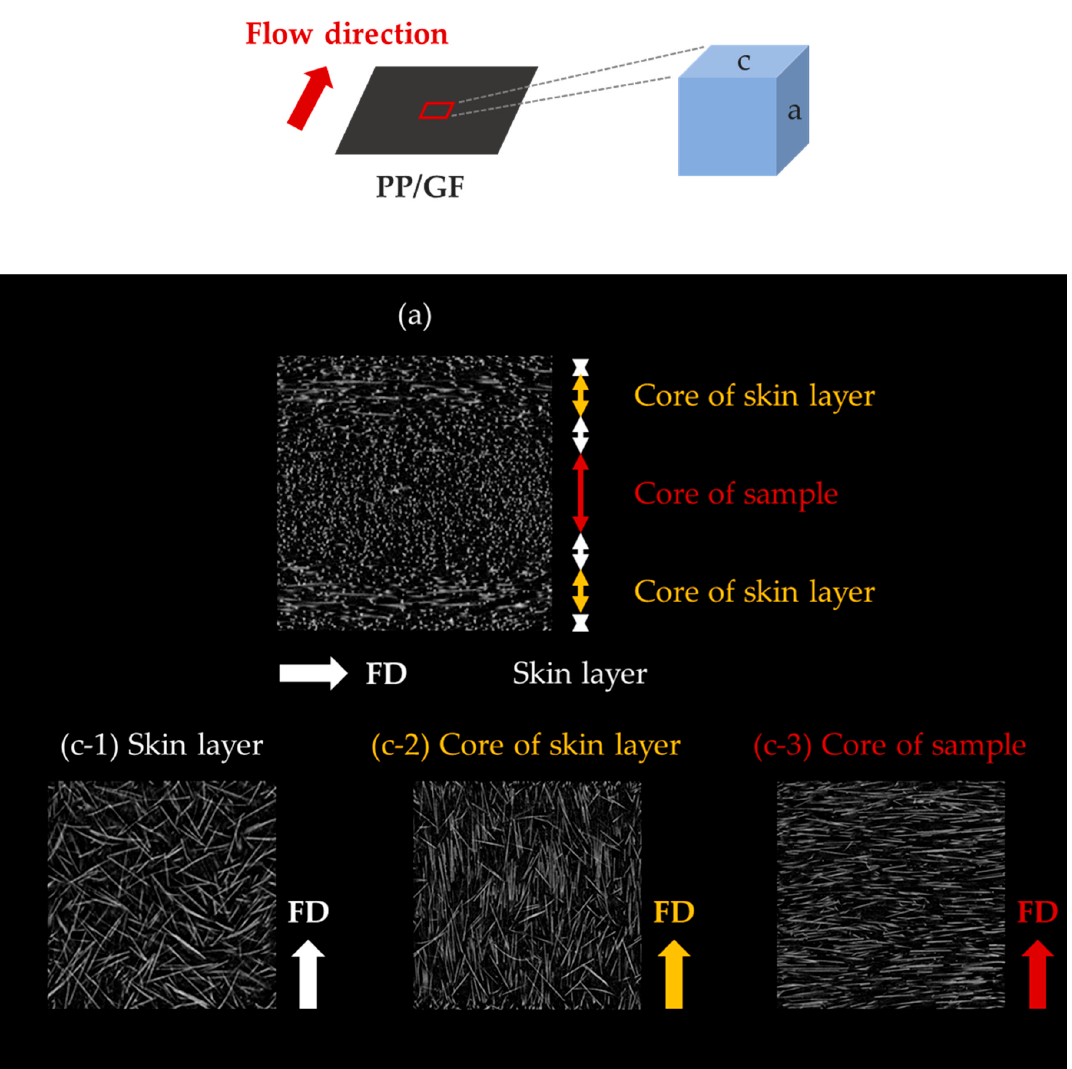
Figure 13. Orientation of glass fiber in PP in the different layers: ( a ) side and ( c ) top.